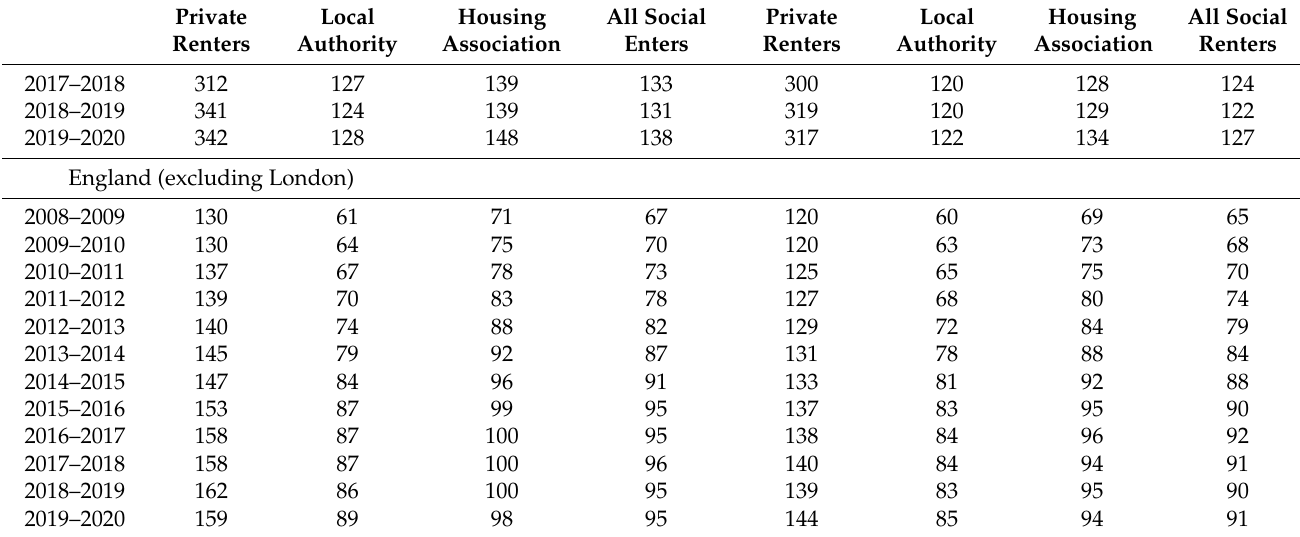
Table A9. Mortgage/rent as a proportion of household income (including and excluding